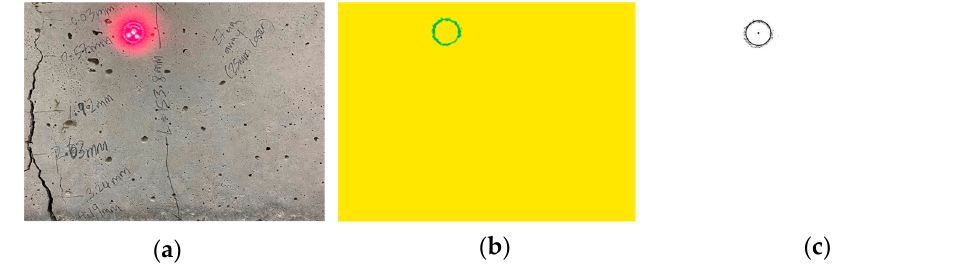
Figure 3. ( a ) Original image; ( b ) color filtered image ( c ) grayscale image with laser detected and center marked. center